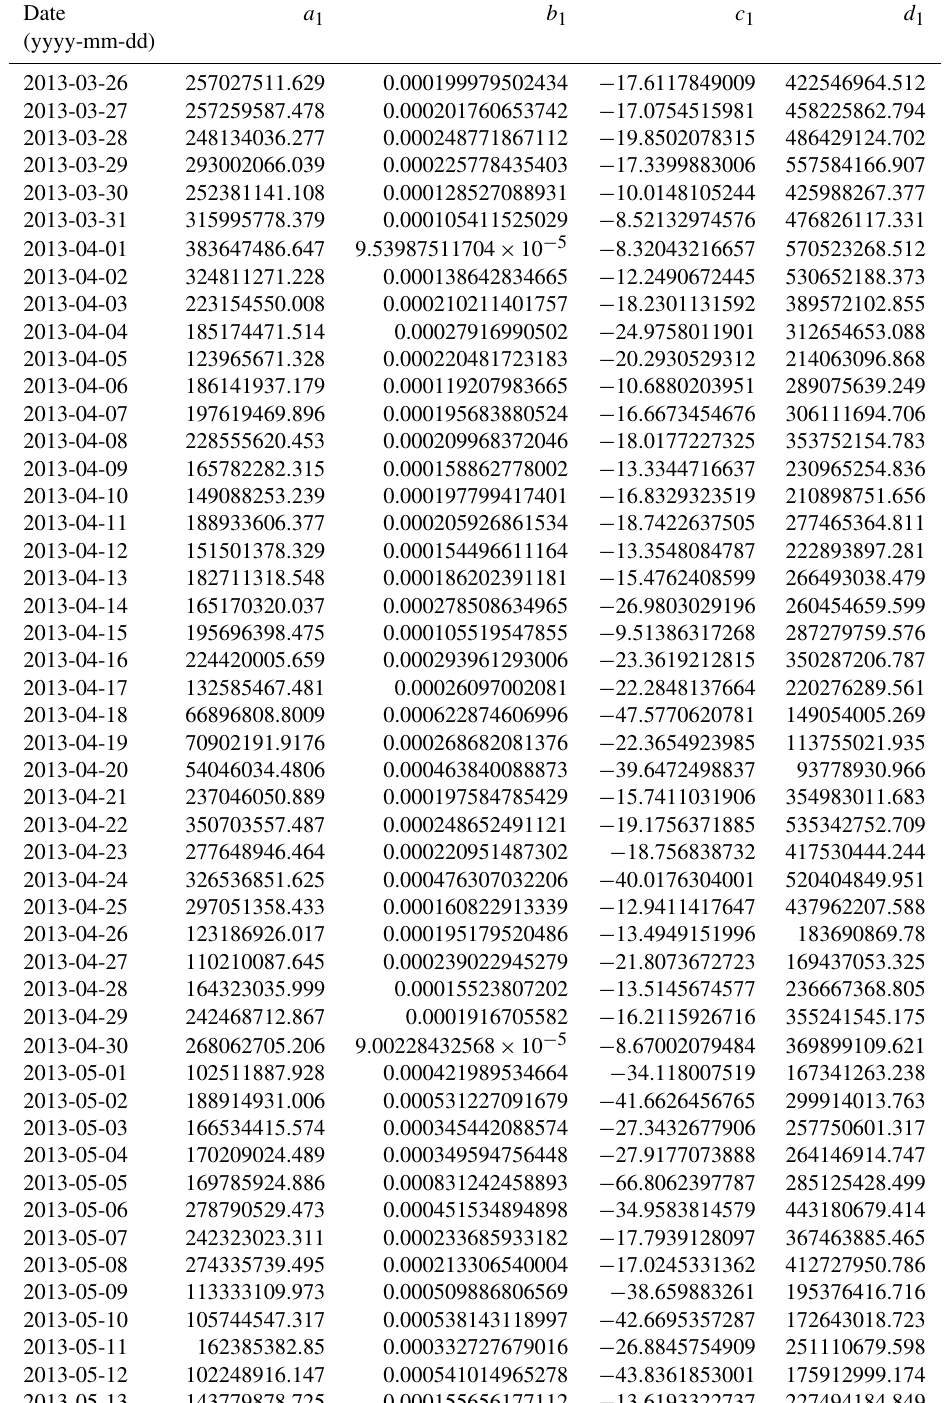
Table A1. Parameters defining the CCN